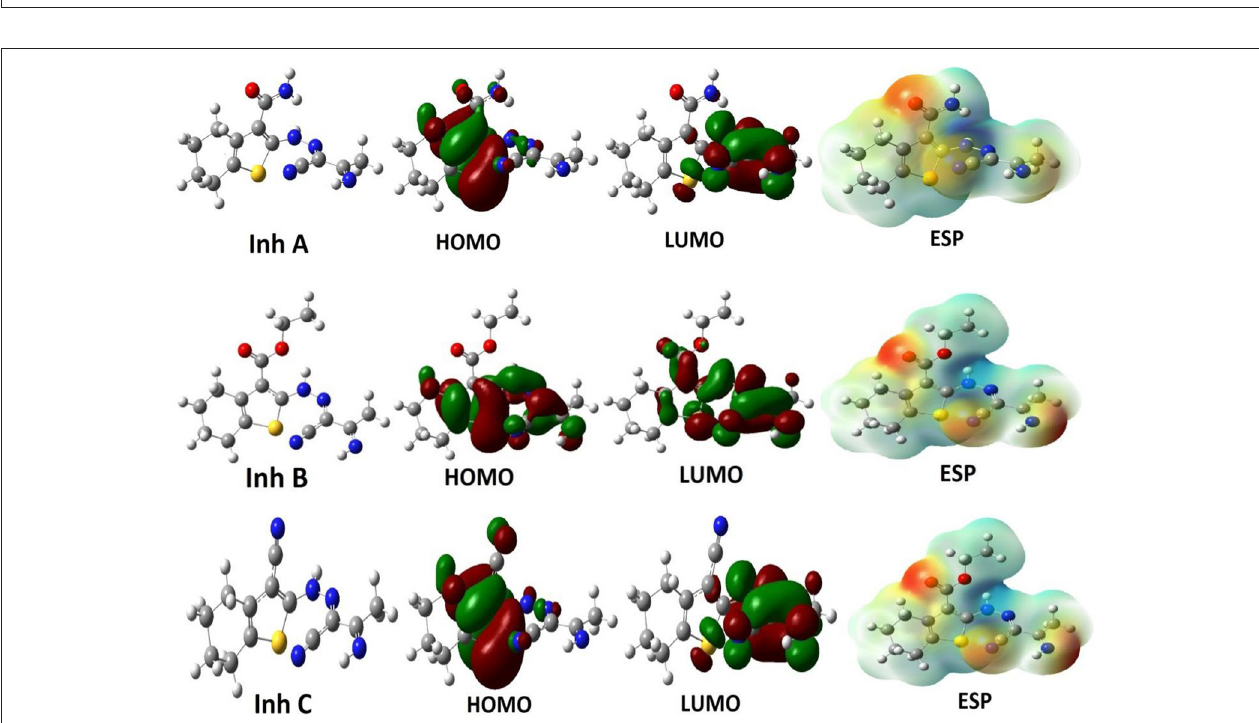
FIGURE 2 | The optimized structures, HOMOs, LUMOs and electrostatic potential structures of studied inhibitor molecules at the DFT/B3LYP/6-31 ++ G level of theory.